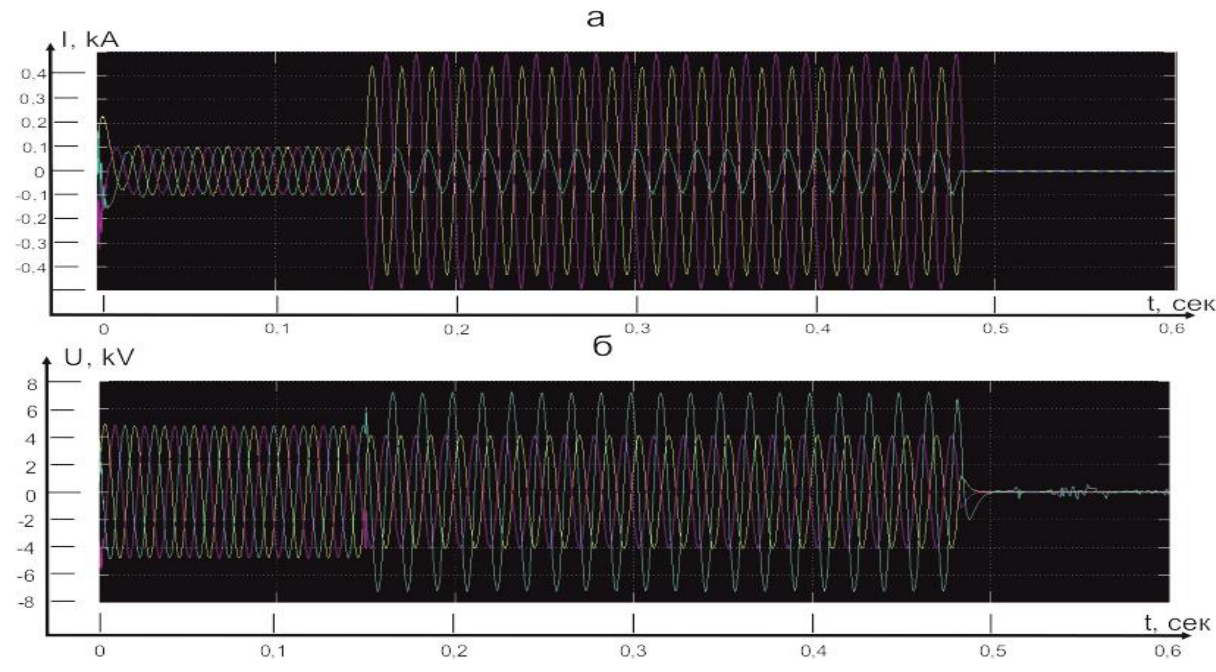
Figure 5. The oscillogram of currents (a), electric potential (b) at the moment